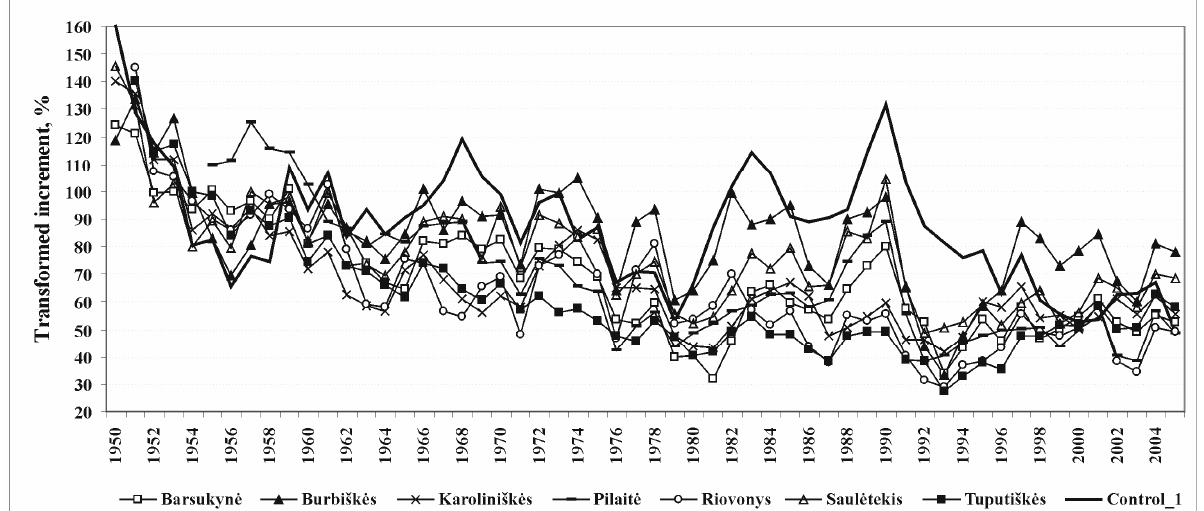
Fig. 3. Transformed dendroscales of 60 – 70 year old pines in Control_1 and Vilnius city sample plots